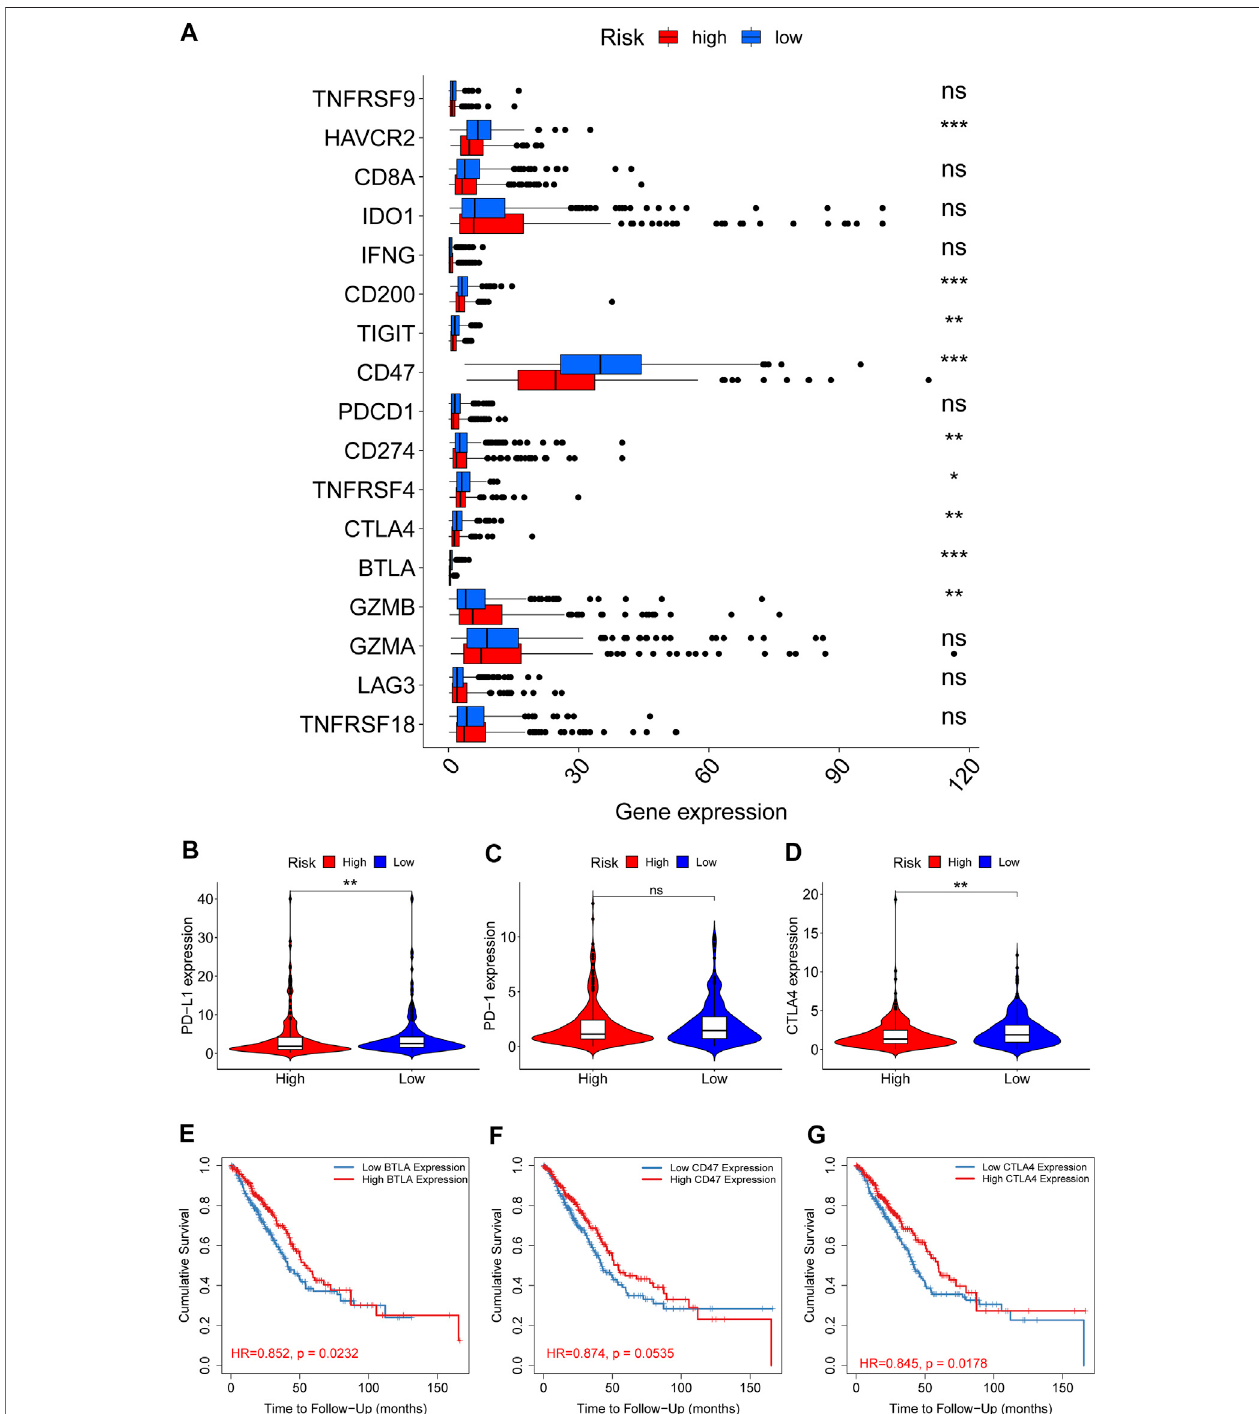
FIGURE 8 | Differences in the expression of immune checkpoint genes between the high- and low-risk groups (A) Box plots show the difference in the expression of immune checkpoint genes between the high- and low-risk group (B – D) Violin plots show the difference in the expression of PD-L1, PD-1, and CTLA4 between the high- and low-risk groups (E – G) Survival curves of BTLA, CD47, and CTLA4 in TIMER. * p < 0.05; ** p < 0.01; *** p < 0.001.